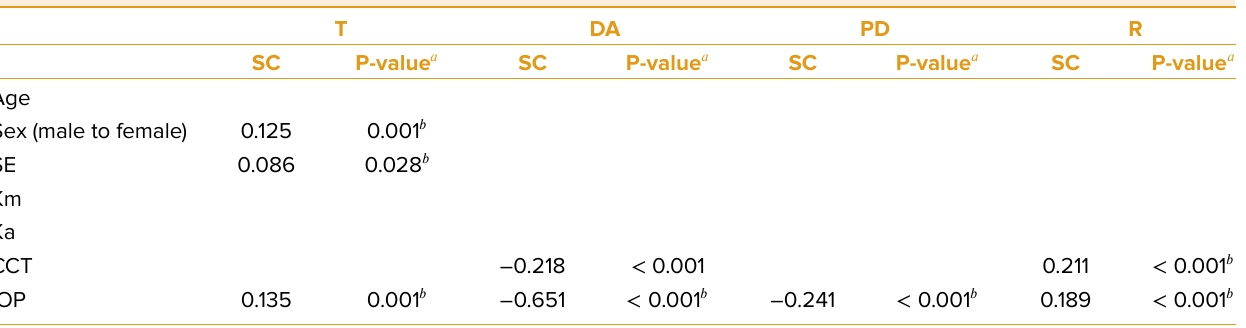
Table 5. Linear regression analysis demonstrating an association between selected demographic and ocular factors to each Corvis ST parameters at the highest concavity moment